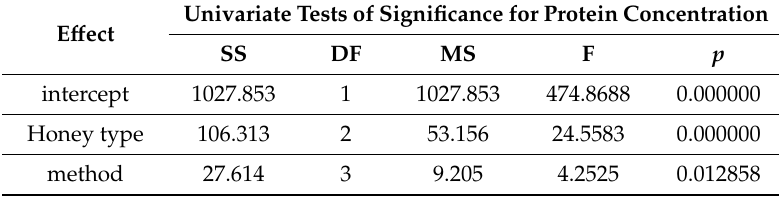
Table 1. Summary of two-way analysis of variance.